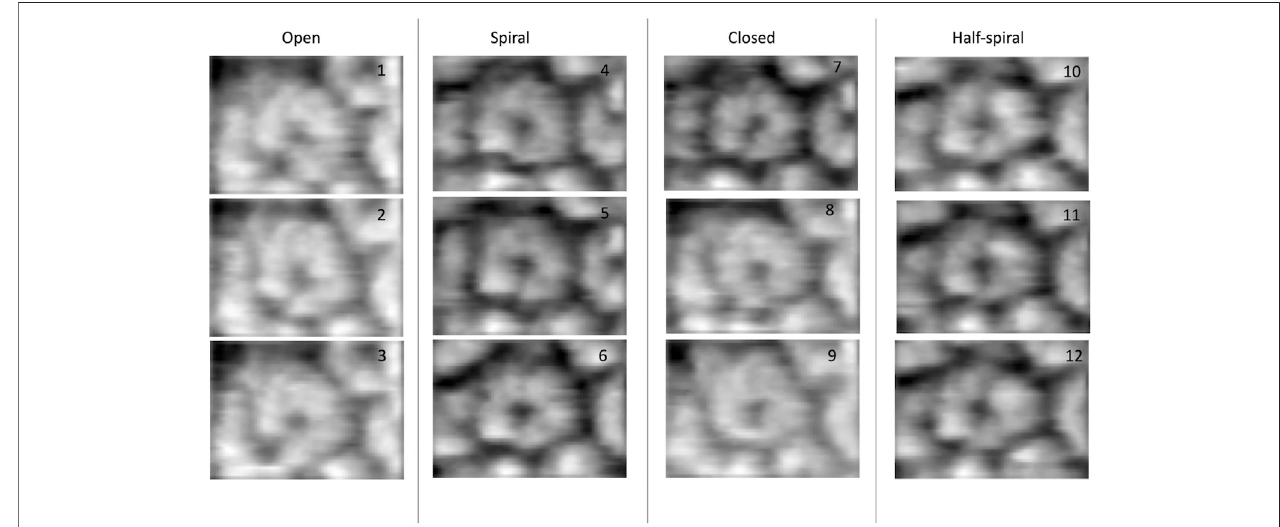
FIGURE 1 | Experimental AFM images used for 3D structure modeling (Uchihashi et al., 2018).